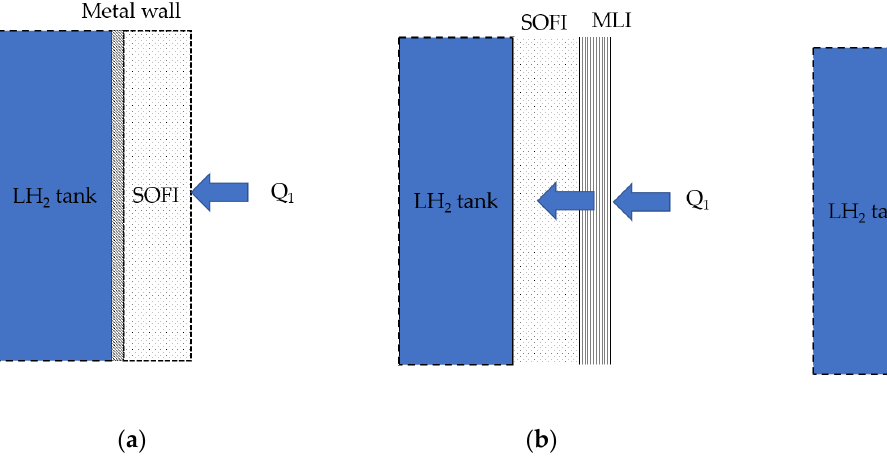
Figure 2. Schematic of insulation system for LH2 tank. ( a ) SOFI; ( b ) SOFI/MLI; ( c ) MLI/VCS. (1)